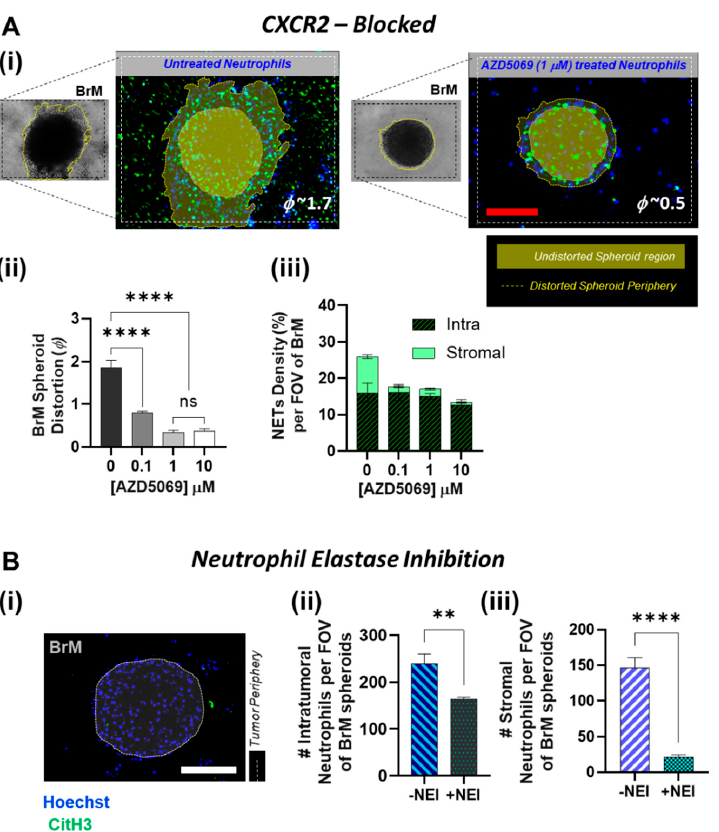
Figure 5. CXCR2-mediated NETs formation and the reciprocal BrM tumor response. ( A ) (i) Representative images of the spheroids (brightfield), showing the infiltration of neutrophils (stained Hoechst blue) and the NETs generated around the spheroids (labeled with citH3 green). Invasive domains (the distorted spheroid periphery) are marked by the dotted lines, and the undistorted spheroid contour prior to tumor invasion is highlighted in the fluorescent images. The invasive domain is distinct by its presence within the stromal collagen region seen out of plane from the rest of the spheroid. The BrM response is measured using the spheroid distortion parameter ( φ ). Treatment of neutrophils with AZD5069 reduces BrM migration and invasion, as qualitatively shown. (ii) Quantification of